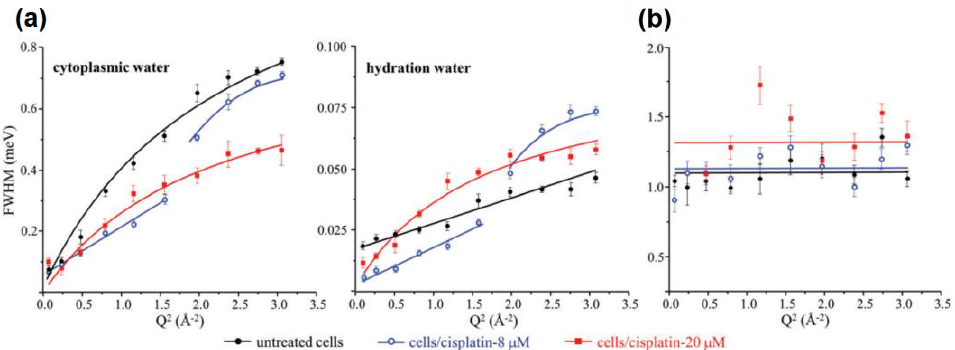
Figure 6. Variation of the full widths at half-maximum (FWHM) with Q 2 for untreated and cisplatin-treated (8 and 20 mM) MDA-MB-231 cells in deuterated saline medium (washed), at 298 k: ( a ) Lorentzian functions representing the translational motions of intracellular water — cytoplasmic and hydration water; ( b ) Lorentzian function representing the internal localized motions within the cell. Reprinted with permission from ref. [53]. Copyright 2017 The Royal Society of Chemistry.